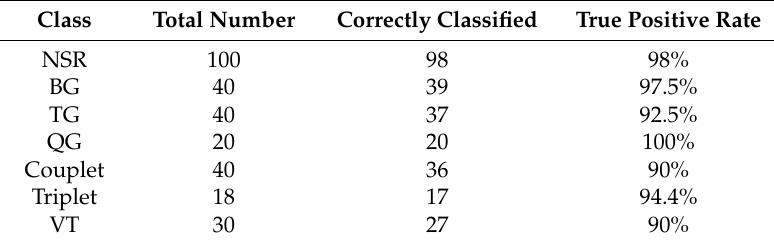
Figure 14. ( a ) Electrocardiogram (ECG) signal including different types of episodes. ( b – d ) Zoomed-in episodes of ( b ) couplet, ( c ) QG, and ( d ) NSR. Table 9. Stage 4: Evaluation results by type of rhythm.